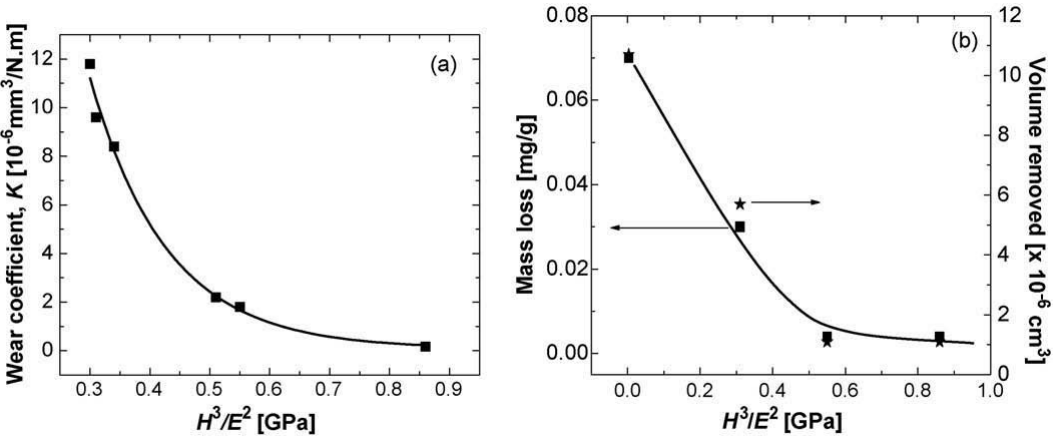
Figure 11. Tribological characteristics of TiN and nanocomposite nc-TiN/SiN 1.3 films as a function of the H 3 /E 2 ratio: ( a ) wear coefficient; ( b ) erosion rate [133].